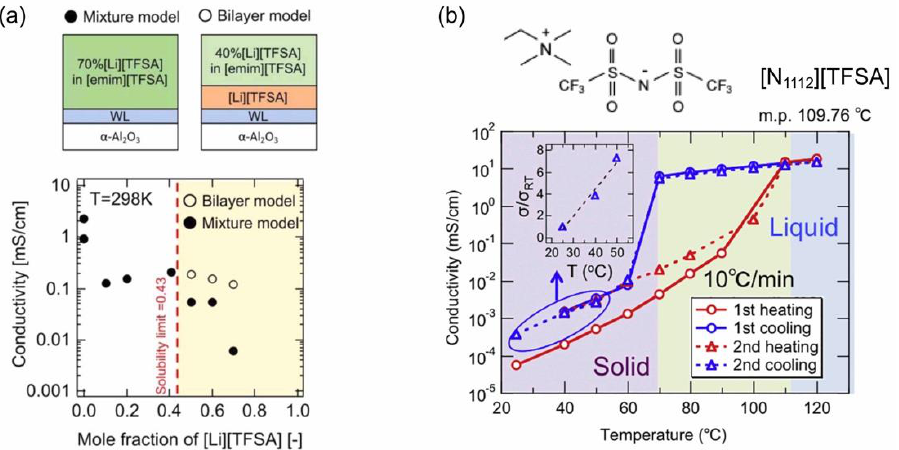
Figure 7. ( a ) Ionic conductivity of Li[TFSA]-[emim][TFSA] solution films, along with two possible solution models with the Li[TFSA] content exceeding the bulk solubility limit. Reproduced with permission from ref. [19]. Copyright 2020, IOP Publishing Ltd. ( b ) Temperature dependence of the ionic conductivity of a [N 1112 ][TFSA] IL film, along with its chemical structure. Reproduced with permission from ref. [33]. Copyright 2019, Elsevier.